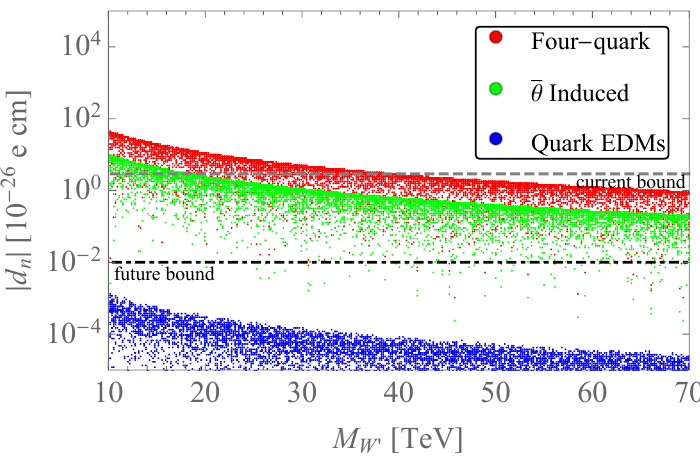
Figure 4 . Comparison between the contribution of the induced (cid:22) (cid:18) to the neutron EDM and others in the presence of Peccei-Quinn mechanism. A gray dashed line represents the current bound of EDM [69] while a black dashed dotted line stands for the future bound